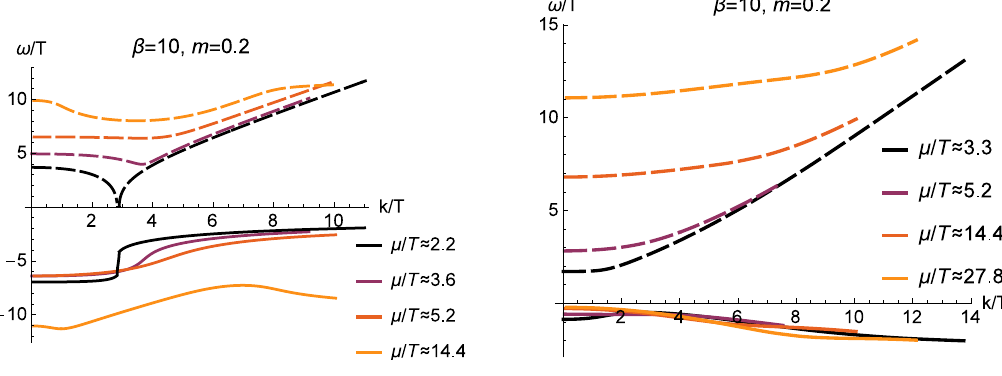
Figure 17 . The gapped QNM (left) and CM (right) at (cid:12) = 10 and m = 0 : 2.